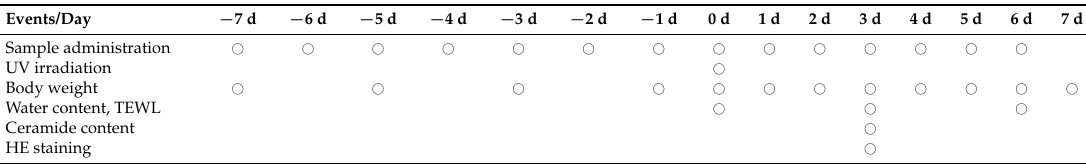
Table 2. Experimental schedule (d: